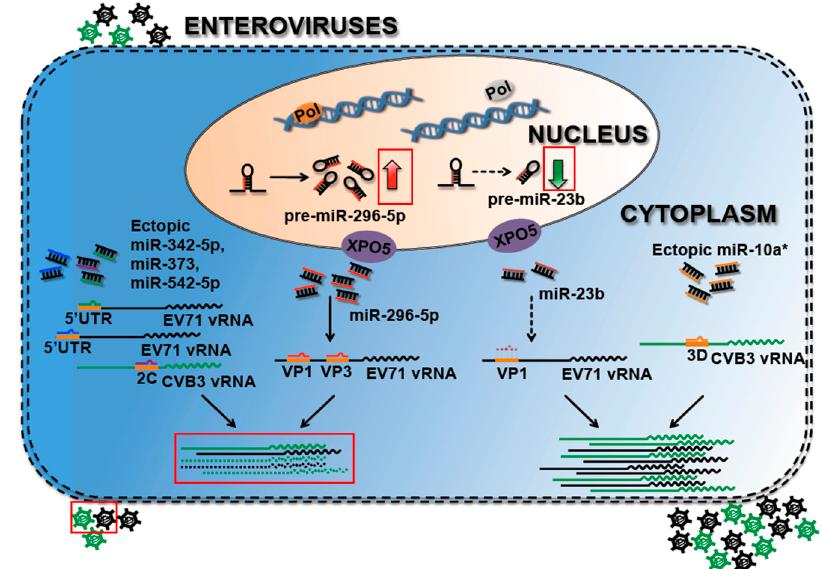
Figure 2. Host miRNAs are involved in the Enterovirus life cycle by targeting to viral genomes. Hexagons indicate Enterovirus, solid lines indicate viral RNAs, dotted lines indicate inhibited viral RNAs, red arrows indicate upregulated expression and green arrows indicate downregulated expression.